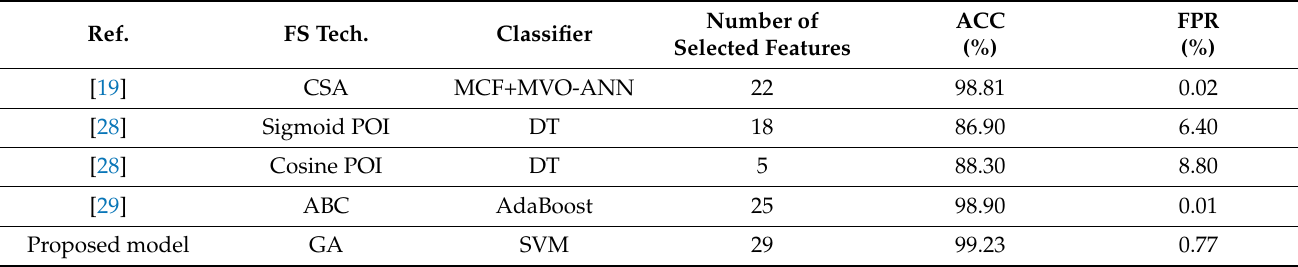
Table 12. Performance comparison with recent methods in NSL-KDD. Ref.